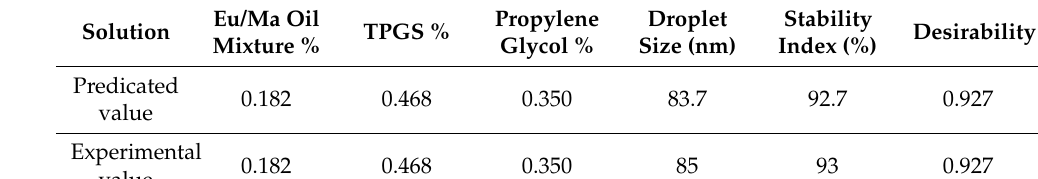
Table 3. Actual and predicted values of the optimized LV-Eu-SNEDDS.